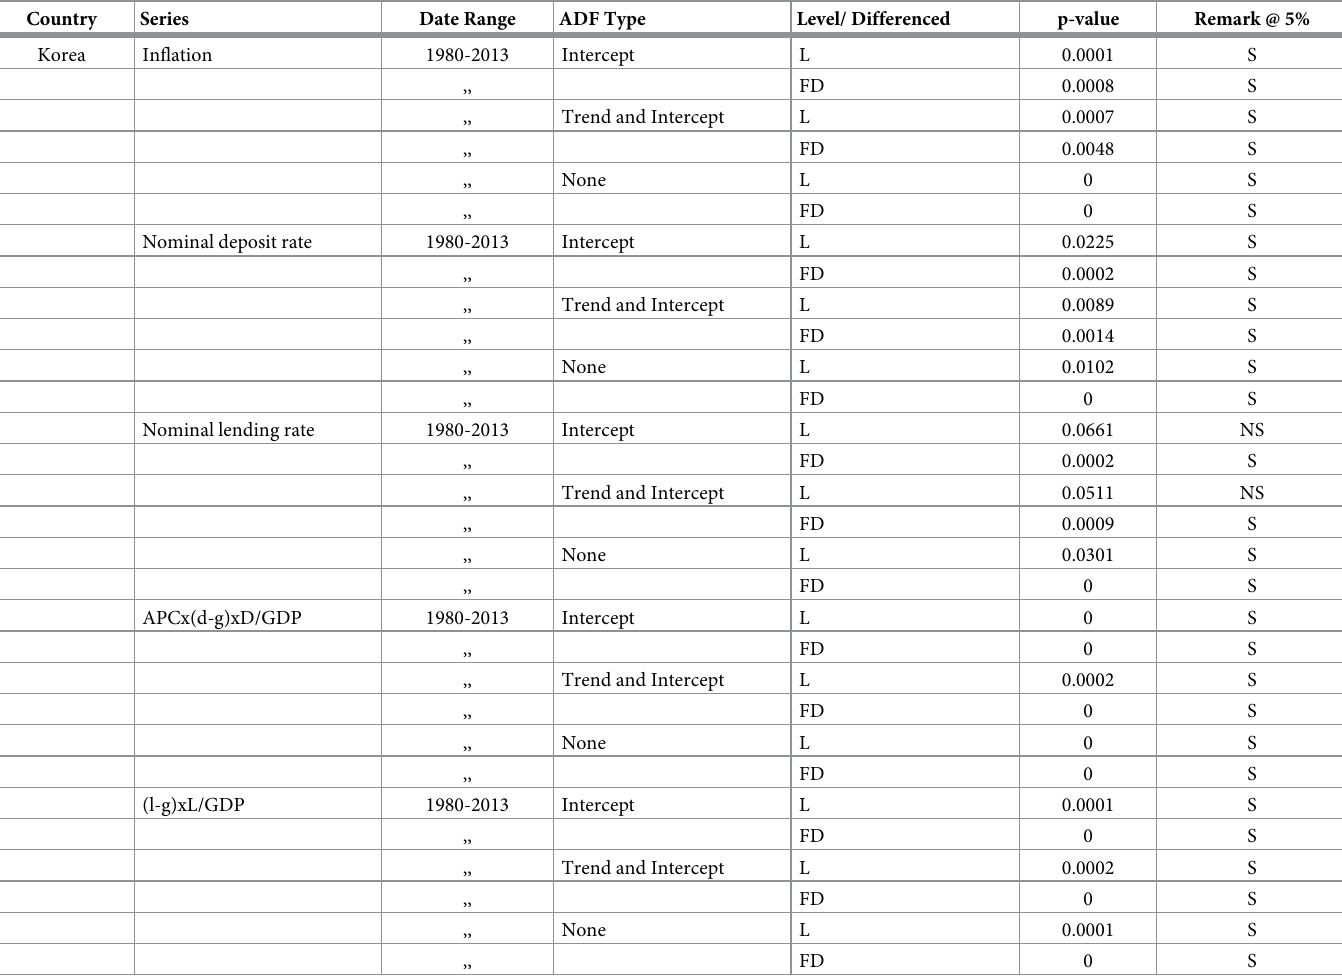
Table 3. ADF Unit Root